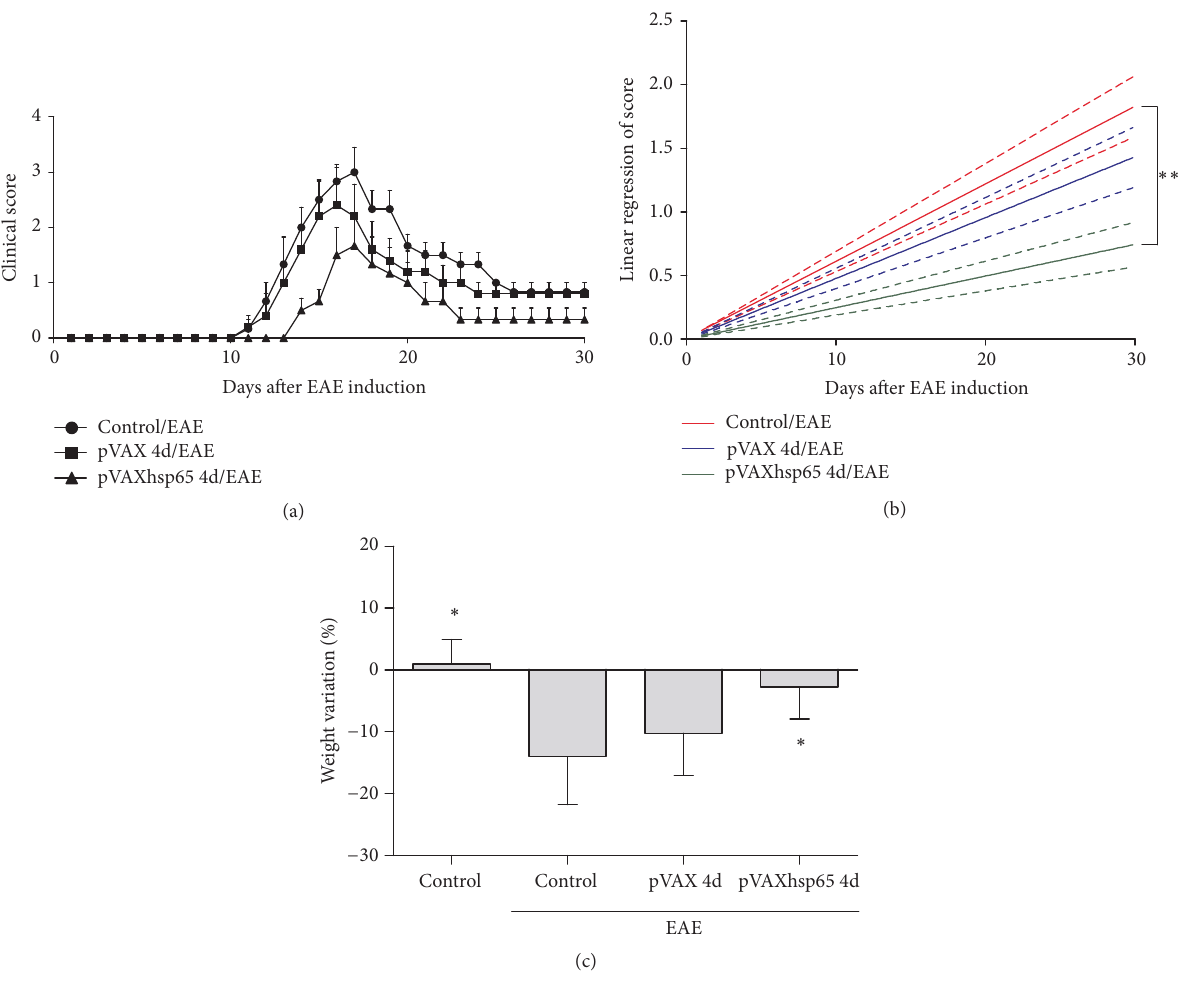
Figure 2: Effect of previous vaccination with pVAXhsp65 on EAE development . C57BL/6 mice were immunized with 4 pVAXhsp65 doses and then submitted to EAE induction. Kinetics of clinical scores (a), linear regression analysis of clinical scores (b), and body weight variation (c). Data were presented by mean ± SE of 6 mice and are representative of three independent experiments. ∗ represents the difference between immunized and control group with EAE. ∗ 𝑝 < 0.05 and ∗∗ 𝑝 < 0.001